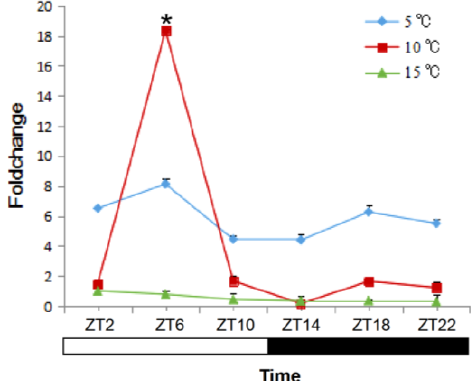
Figure 5. Quantification of sjCRY-DASH transcriptional levels under different temperatures. Juvenile sporophytes of S. japonica were grown under the light/dark (LD) 12:12 cycle and harvested at 4 h intervals. The expression levels at the treatment times are presented as the fold change relative to that at ZT2. Each test was performed in six biological samples. The data in the figures represent the averages ± standard deviation. * p < 0.05 based on one-way ANOVA.